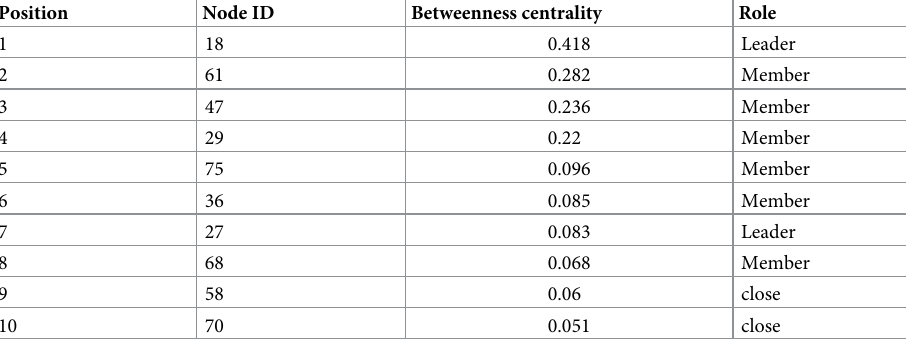
Table 3. Betweenness centrality value and role (Phone Calls network). Position Node ID Betweenness centrality Role